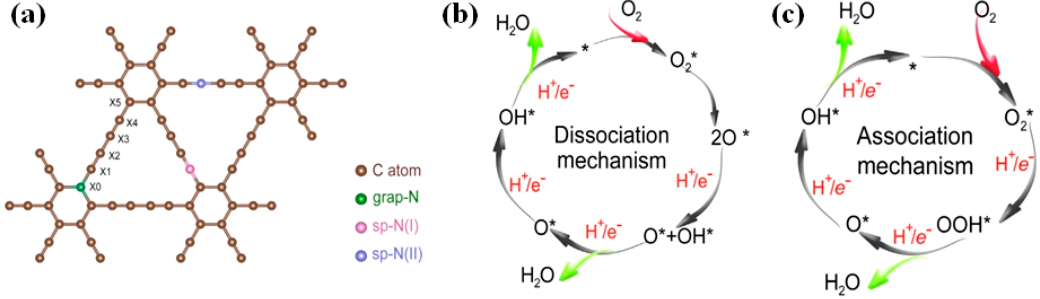
Figure 8. Geometric structure and oxygen reduction reaction (ORR) mechanisms of N-atom-doped GDY. ( a ) Three types of N-atom-doped GDY; ( b ) ORR-dissociation mechanism diagram; ( c ) ORR-association mechanism diagram (reproduced with permission from [108]. Copyright Science China Press, 2019).